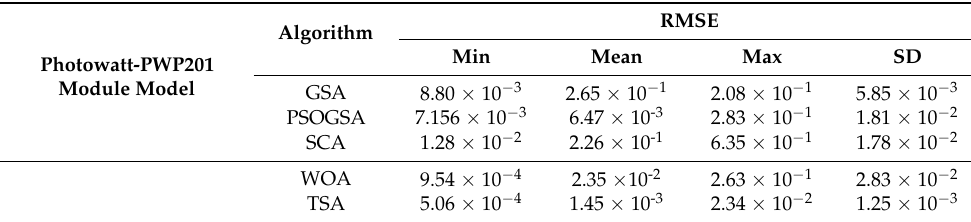
Table 4. Statistical results of the root mean square error (RMSE) of different algorithms for Photowatt- PWP201 PV